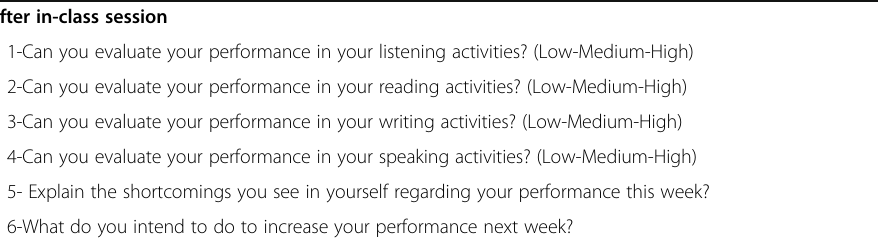
Table 6 FCM_SRL Self-reflection Form Questions